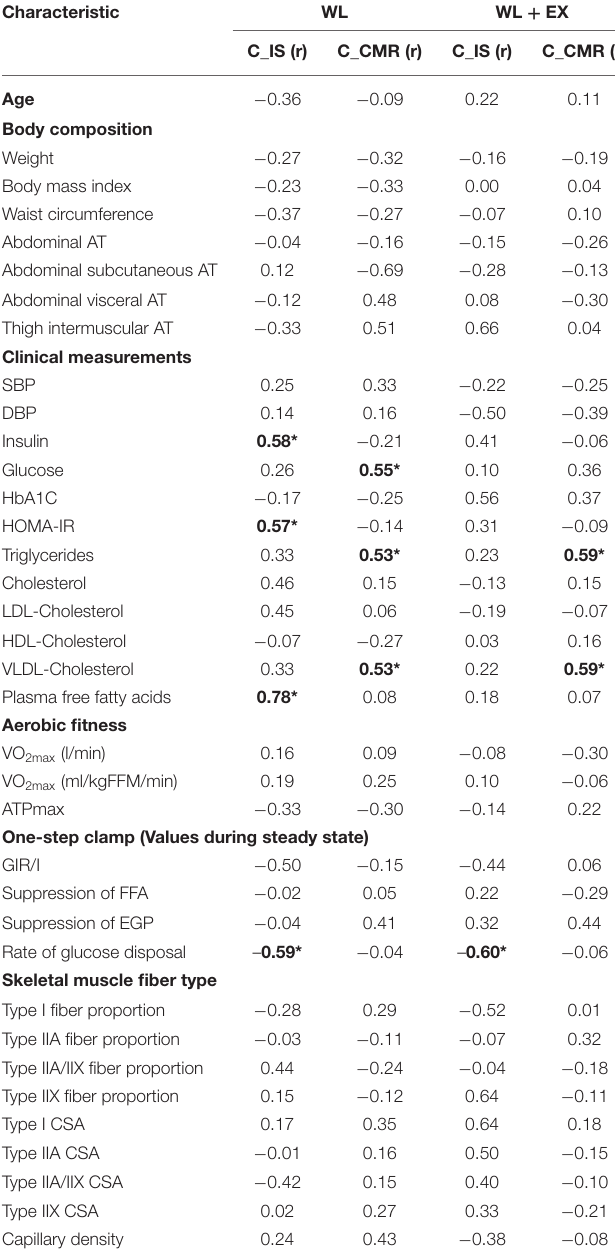
TABLE 2 | Associations between baseline characteristics and